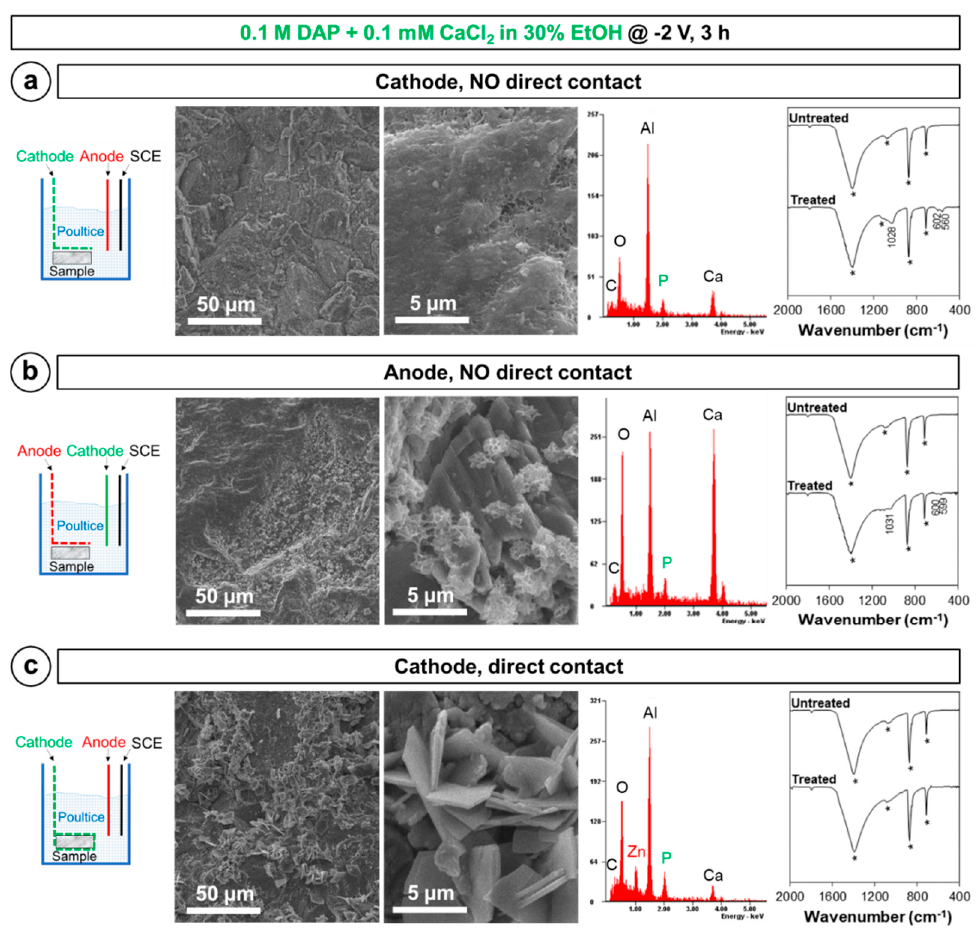
Figure 4. Morphology and composition of the new phases formed by placing the marble sample ( a ) at ~3 mm from the cathode, ( b ) at ~3 mm from the anode, and ( c ) directly in contact with the cathode. EDS spectra were acquired in the whole left SEM image. In the FT-IR spectra, bands owing to the substrate are marked by a star, while the position of the new bands owing to CaP phases is reported.